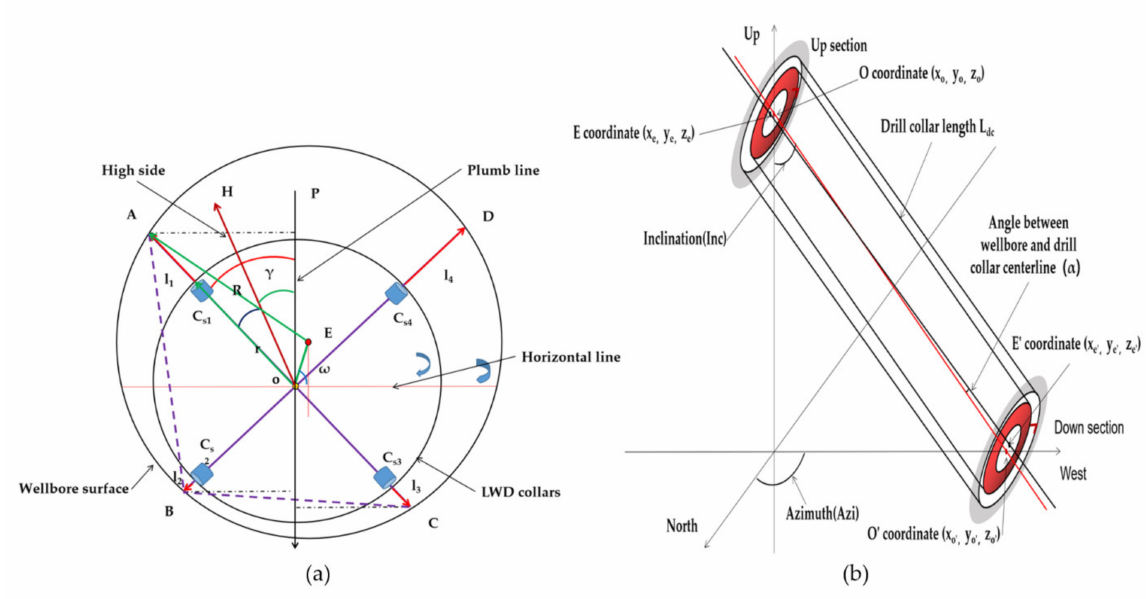
Figure 7. ( a ) Drill string eccentricity diagram section; ( b ) The drill string is eccentric in the wellbore. In Figure 7a, point H is the high edge of the instrument in line with 0 ◦ of the tool surface corresponding to the gyro measuring instrument. Points A, B, and C are the corre- sponding measurement points of ultrasonic sensors C S1 , C S2 , and C S3 on the borehole wall. Angle ∠ HOA is the measurement tool face angle difference of the instrument, which can be measured on the ground and is a known fixed value. ∠ POH is the tool face angle of